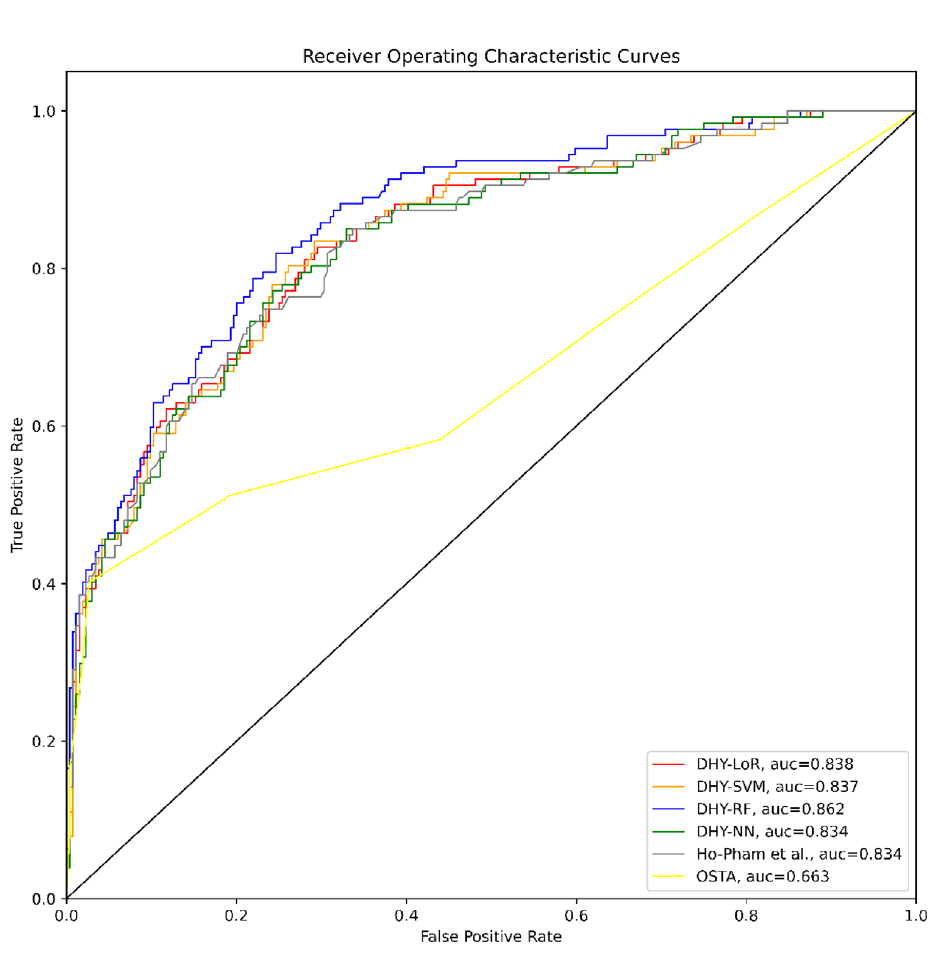
Figure 2. The ROC curves in the first